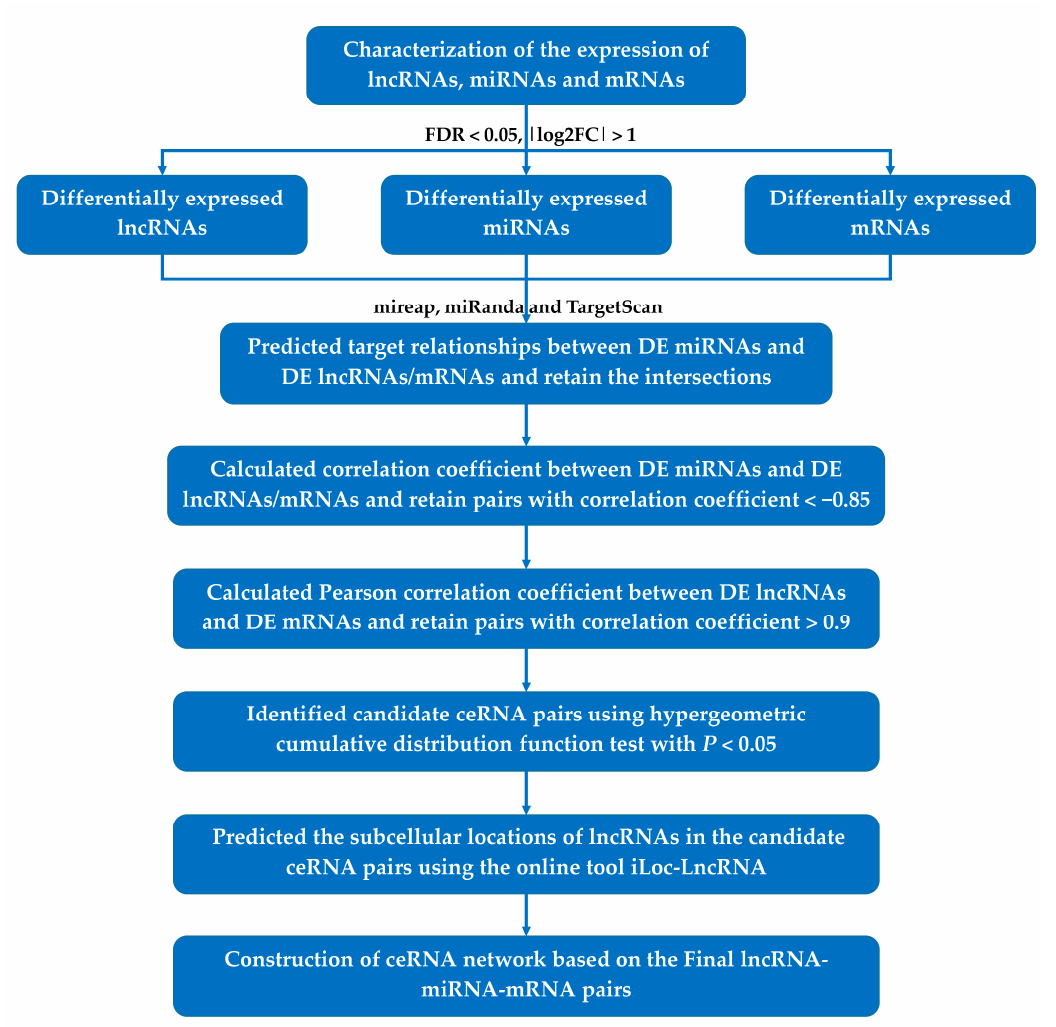
Figure 1. ceRNA network construction flowchart. FDR: false discovery rate, log2FC: log2 fold change, DE: differentially expressed, ceRNA: competitive endogenous RNA, lncRNA: long non-coding RNA, miRNA: microRNA, mRNA: messenger RNA.